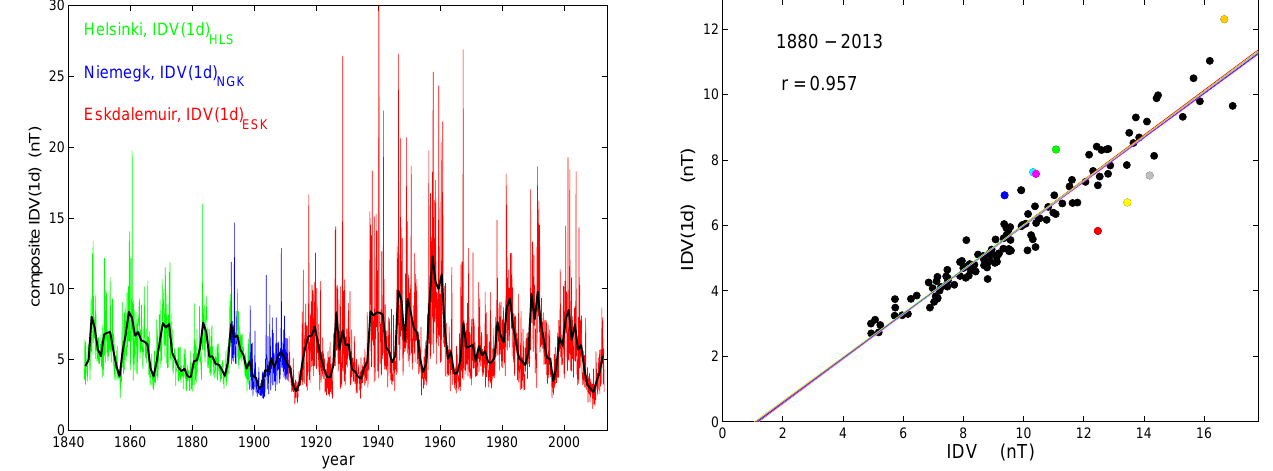
Fig. 12. Scatter plot of annual means of the IDV(1d) composite, shown in Fig. 8, as a function of the IDV index, as derived by SC10, against those for 1880–2013, using the same format as Fig. 3. The correlation coefficient is r = 0 . 957 and removing outliers makes al- most no difference to the regression fit because the correlation coef- ficient is so high. The best-fit regression slope is s = 0 . 678 and the intercept is c = − 0 . 765nT.